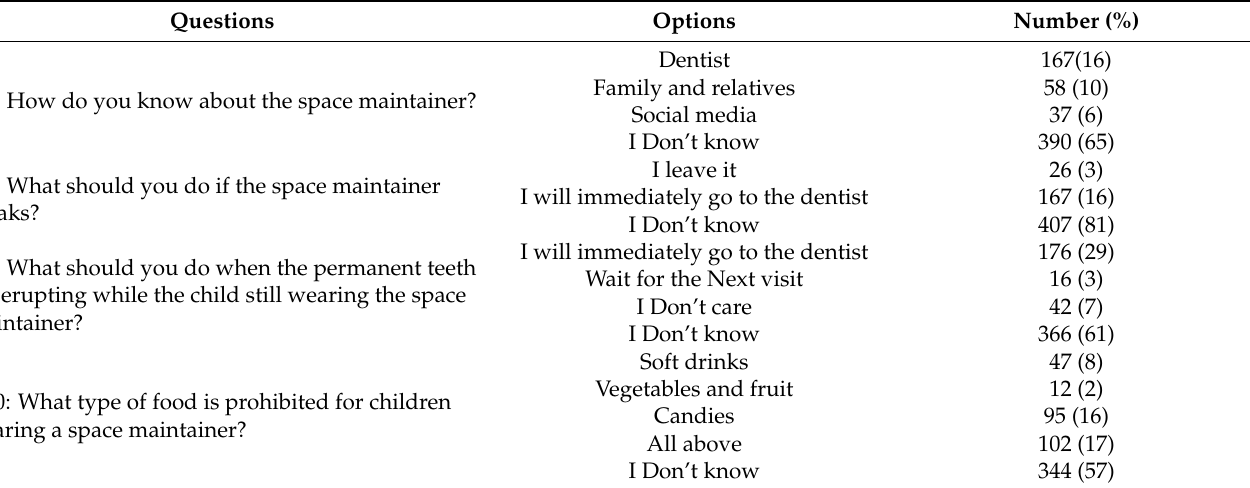
Table 3. Distribution of study participants according to responses for questions with answering scheme of different options.